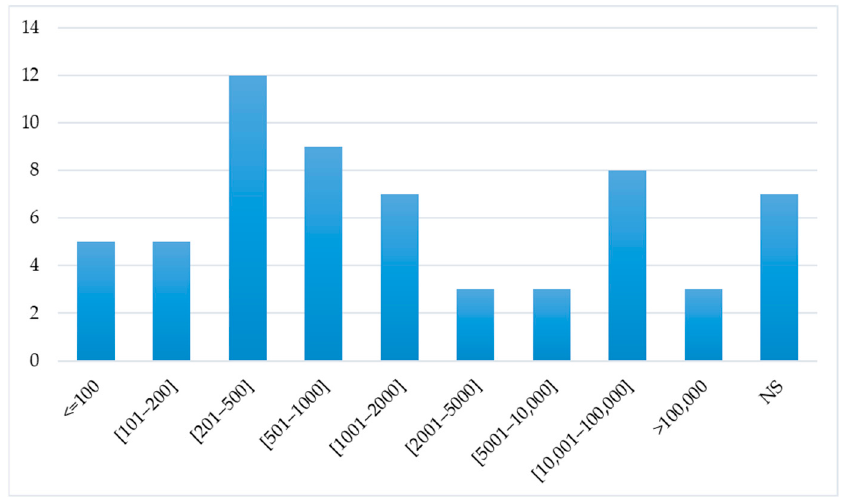
Figure 10. Frequency of studies based on the number of students in the experimental